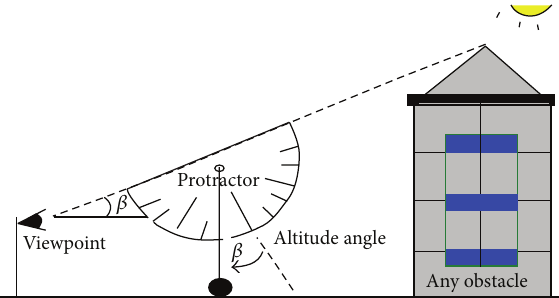
Figure 6: Using a protractor and plumb to measure altitude angle for any obstacles such as mountains, buildings, and trees.